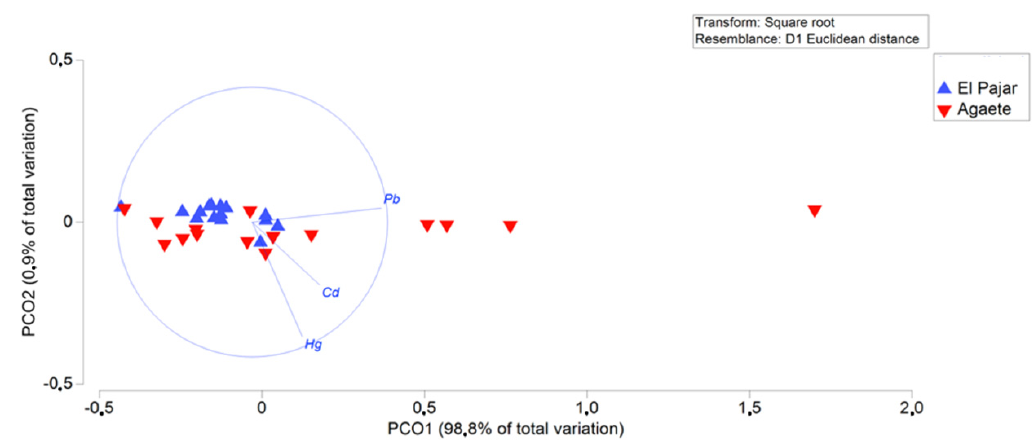
Figure 6. Principal Coordinate Analysis (PCoA) of the exoskeleton with the location factor.